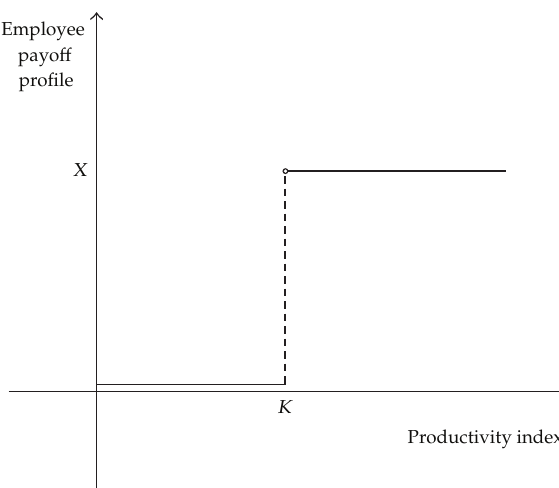
Figure 1: Corporate finance: executive incentive